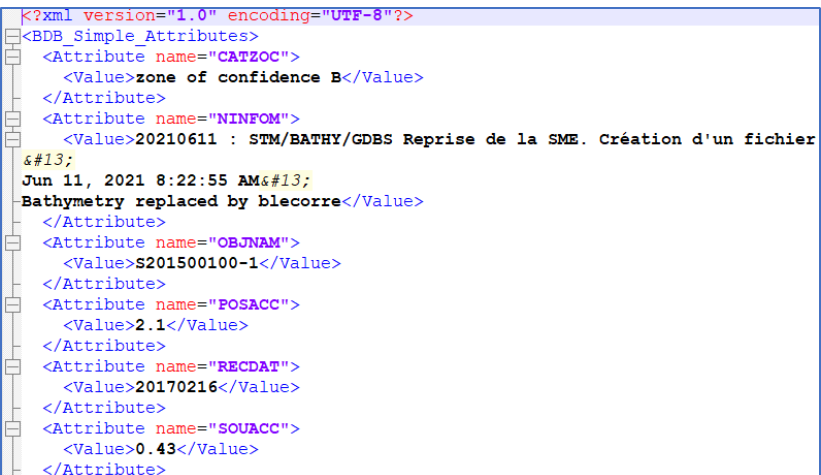
Figure 3. Classic metadata file with S-57 [19] attributes.